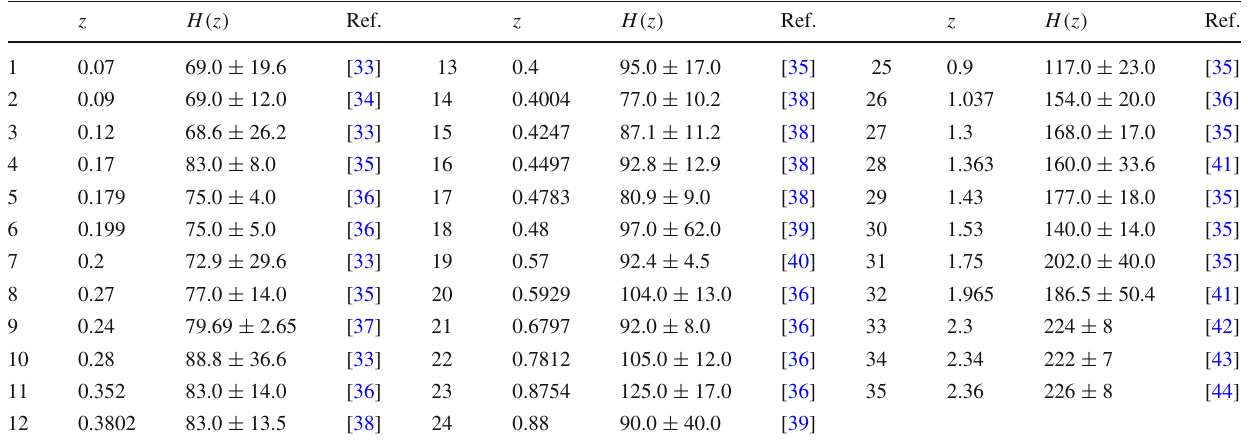
Table 1 H ( z ) data